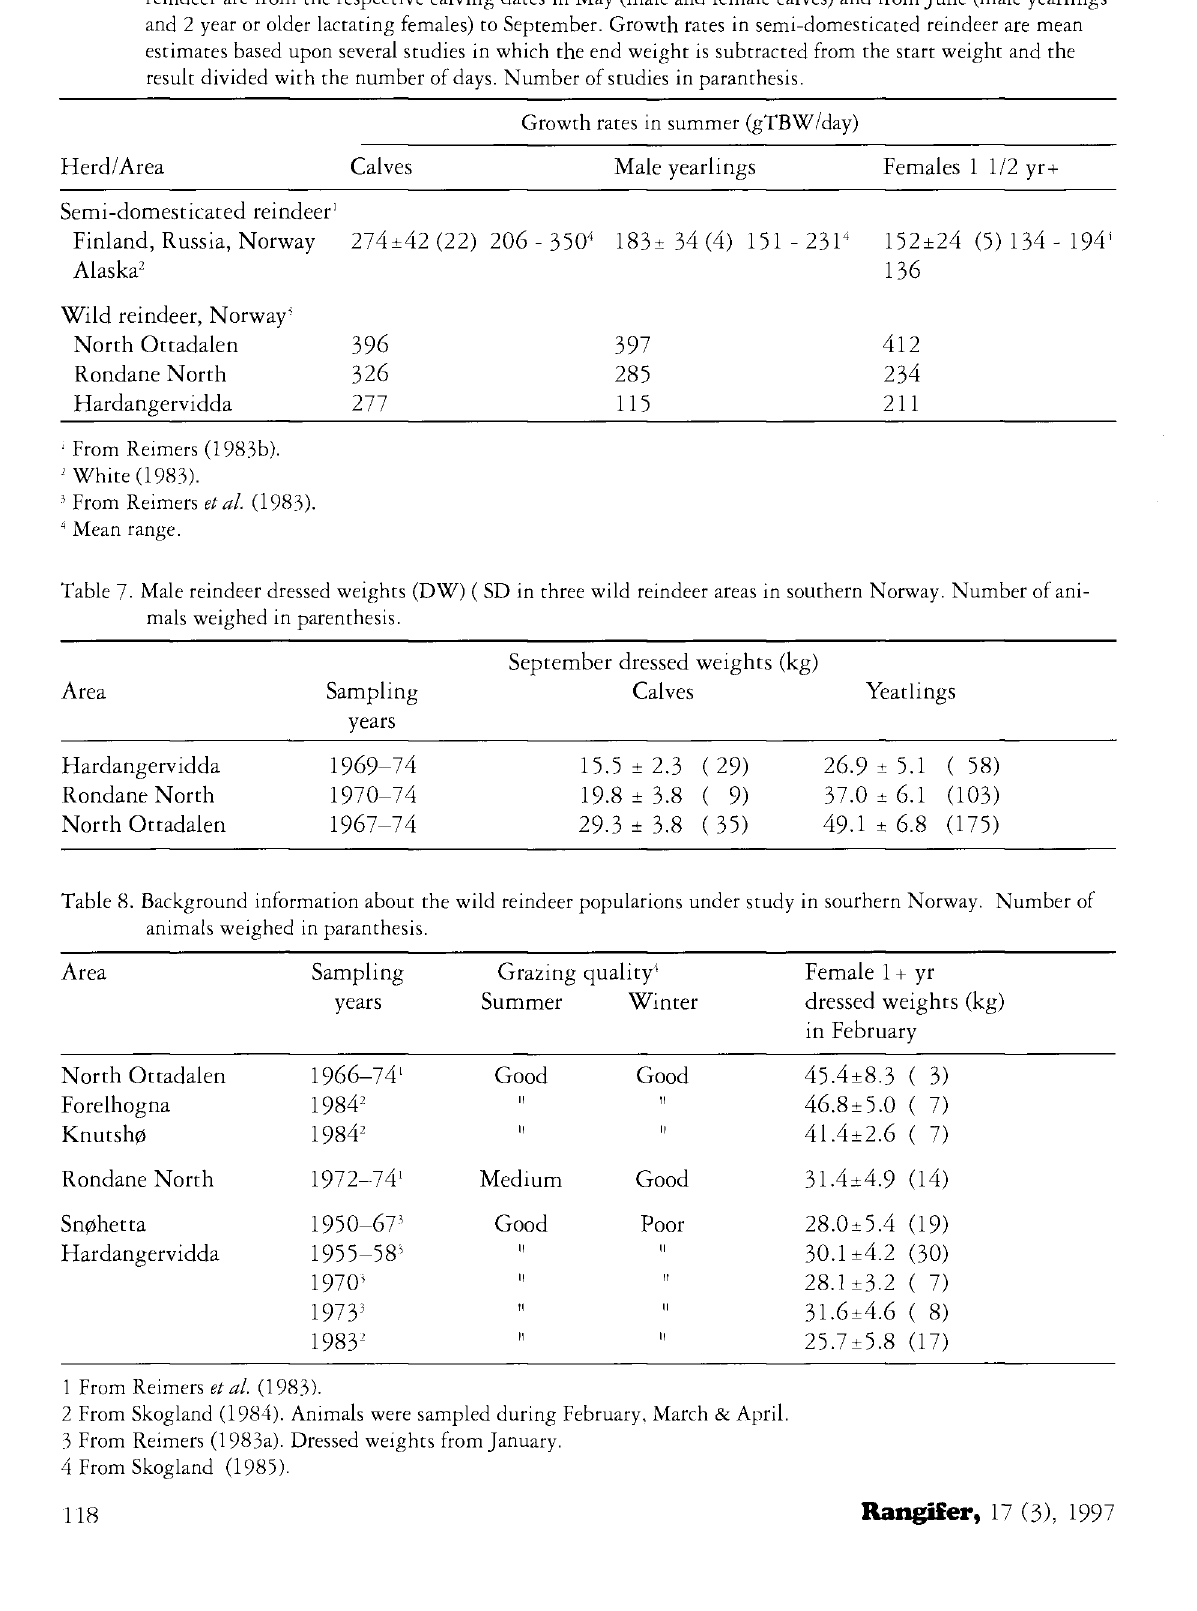
Table 6. Mean summer growth rates (gTBW/day ± SD; TBW = total body weight) in reindeer. Growth rates in wild reindeer are from the respective calving dates in May (male and female calves) and from June (male yearlings and 2 year or older lactating females) to September. Growth rates in semi-domesticated reindeer are mean estimates based upon several studies in which the end weight is subtracted from the start weight and the result divided with the number of days. Number of studies in paranthesis.